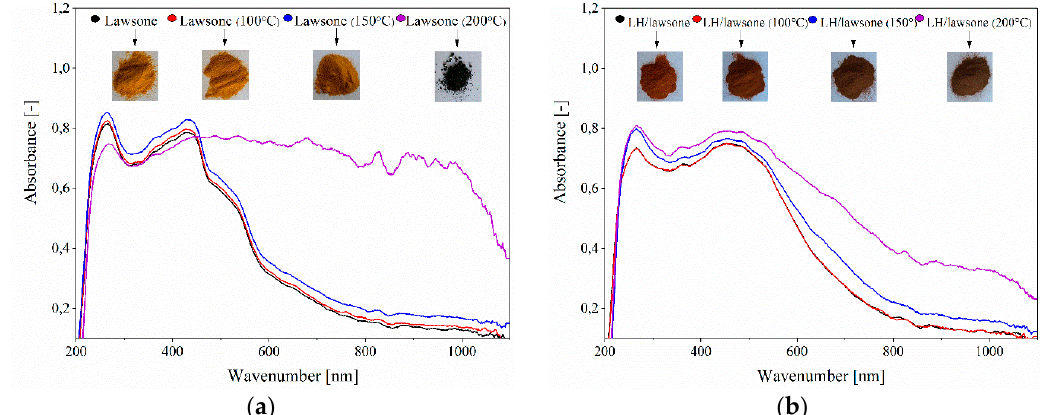
Figure 7. Color changes in lawsone ( a ) and lawsone pigment ( b ) after thermal aging at different temperatures.